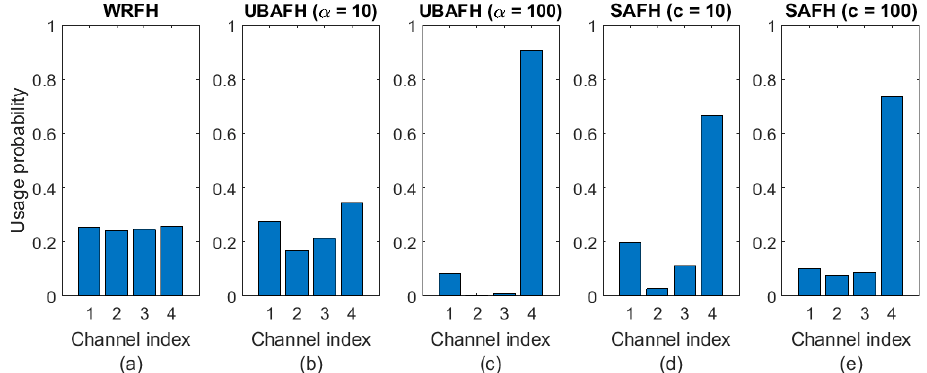
Figure 12. Comparison of channel usage between different frequency hopping techniques: ( a ) WRFH; ( b ) UBAFH with α = 10; ( c ) UBAFH with α = 100; ( d ) SAFH with c = 10; ( e ) SAFH with c =